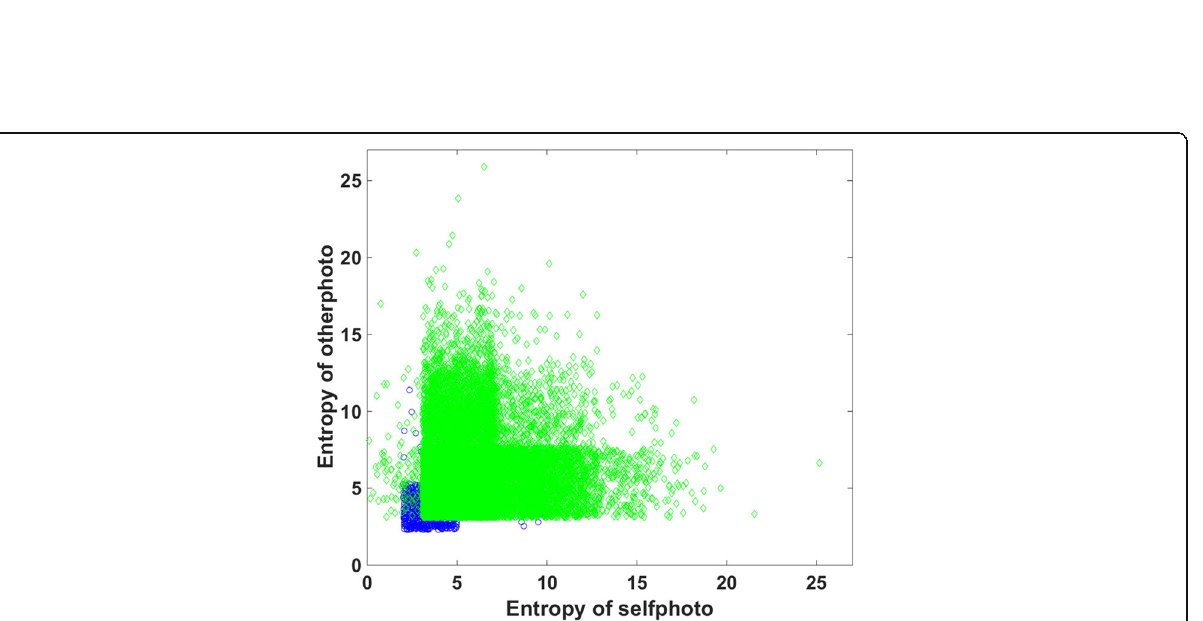
Fig. 2 The effect of the number of electrodes on the accuracy. (1) is the effect of the number of electrodes on the accuracy. In (1), the x -axis is the number of electrodes, y is the Fisher distance, and 1.2 x represents the number of electrodes, where 0 is used only for the two electrodes on the forehead, y indicates the classification accuracy, and (2) shows the effect of the number of electrodes on the Fisher